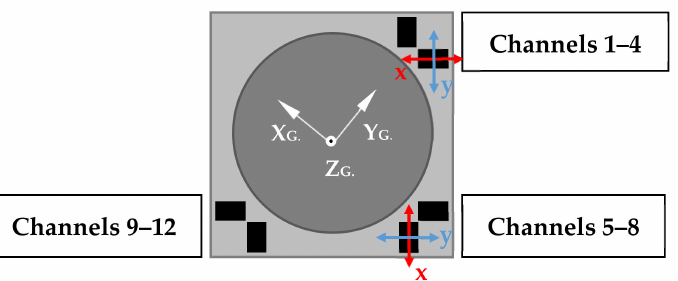
Figure 10. Schematic of data channel layout in a filler brick showing the orientation of local sensor axes and the global MLA axes.